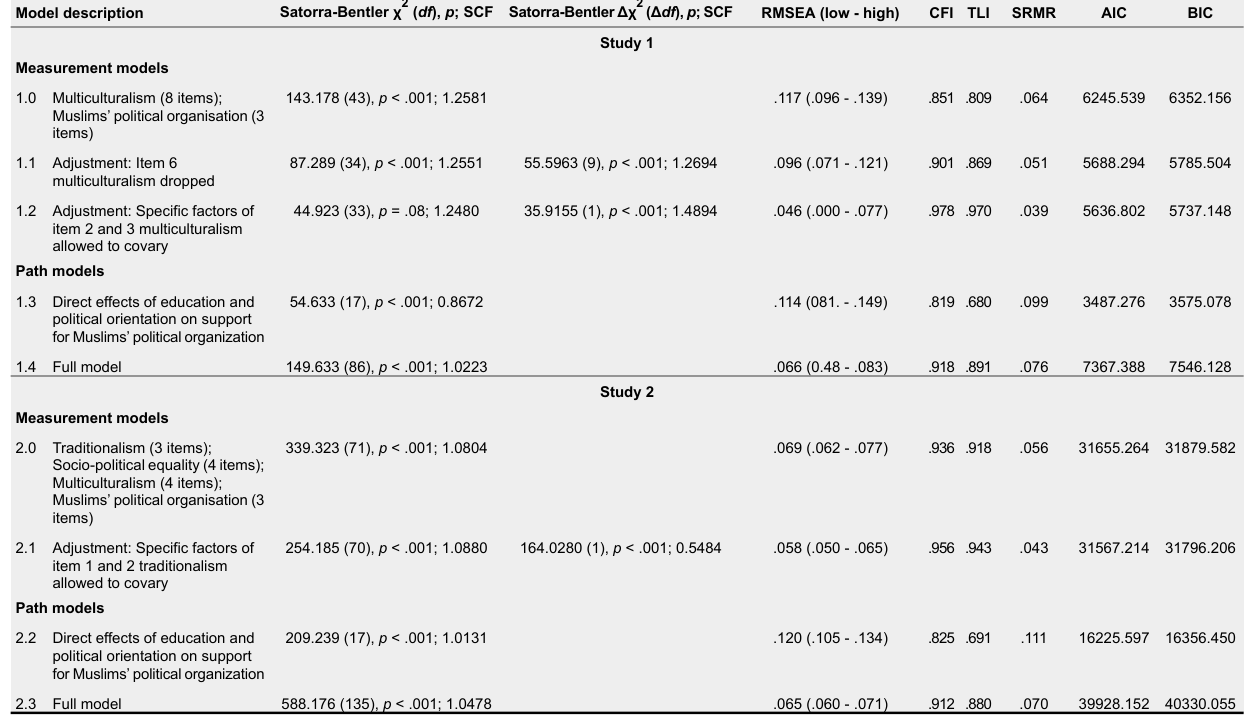
Model Fit Statistics of Measurement Models and Path Models From Study 1 and Study